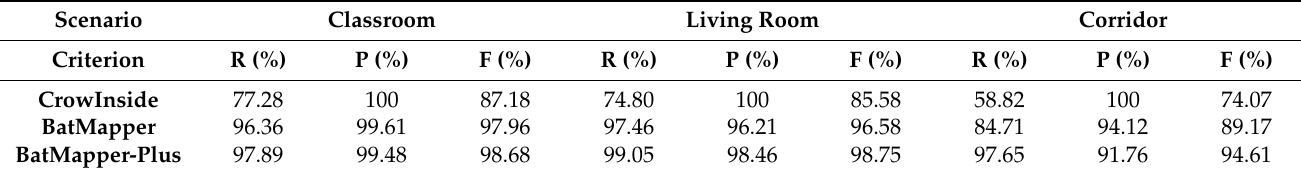
Table 1. Evaluation of floor plans.